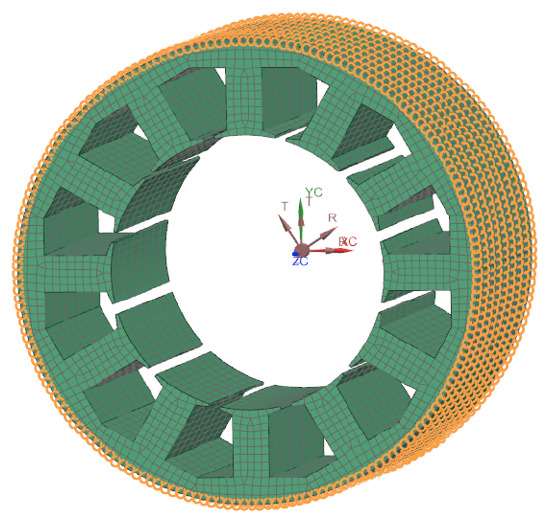
Figure 6. Parametric stator mesh having 19.521 nodes and the output nodes (with orange).